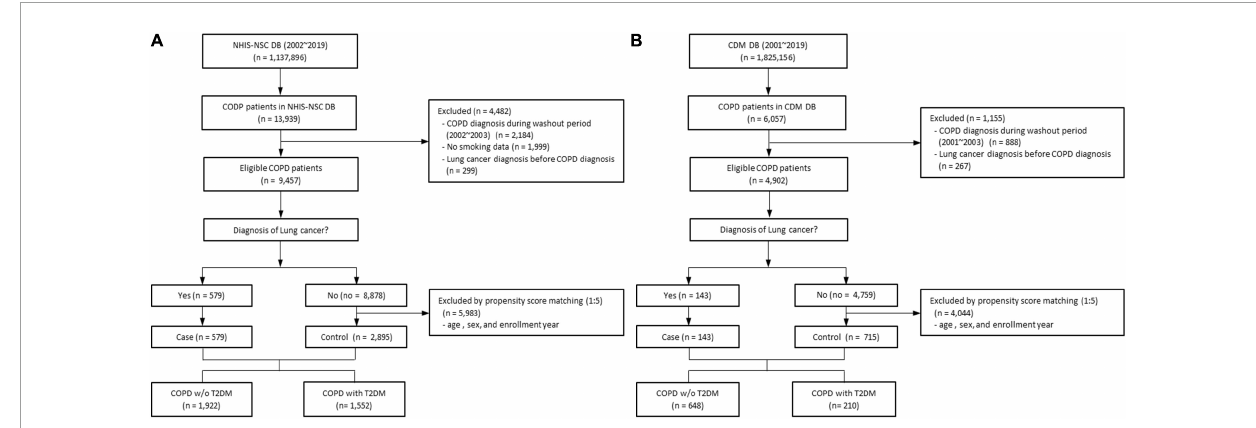
FIGURE1 Flow chart of study design of (A) the NHIS-NSC and (B) the CDM cohort. CDM, common data model; DM, database; NHIS-NSC, national sample cohort of National Health Insurance Service; T2DM, type 2 diabetes mellitus; w/o, without.